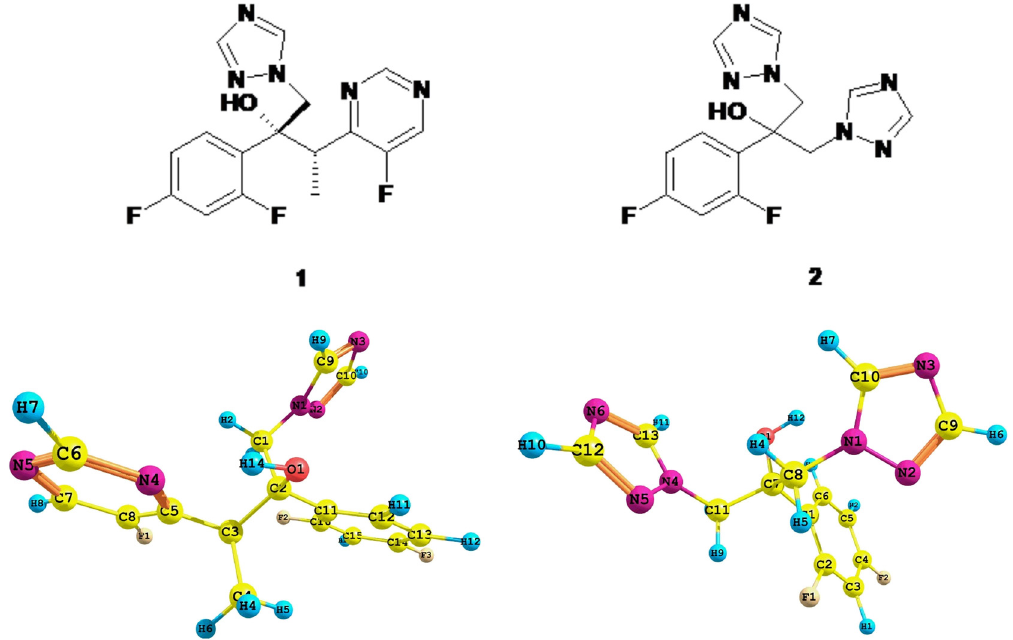
Figure 1: Formulas for voriconazole ( 1 ) and fl uconazole ( 2 ) and their optimized geometry at the B3LYP/6 - 311 + G ( d,p ) ( left ) or M06L/6 - 31G ( d,p ) levels of theory ( right )